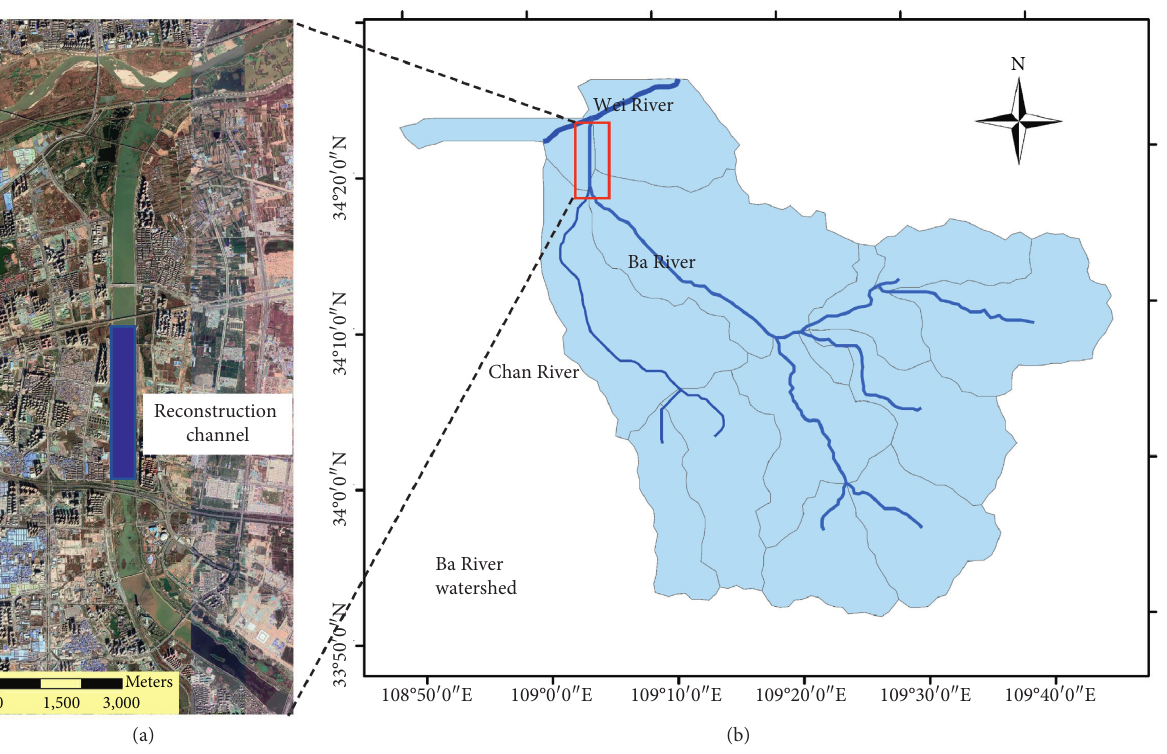
Figure 1: Location of the project area: (a) project river channel; (b) watershed of the Ba